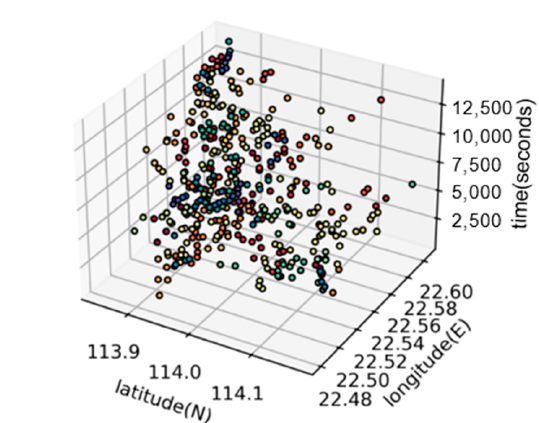
Figure 10. Hierarchical-clustering results.